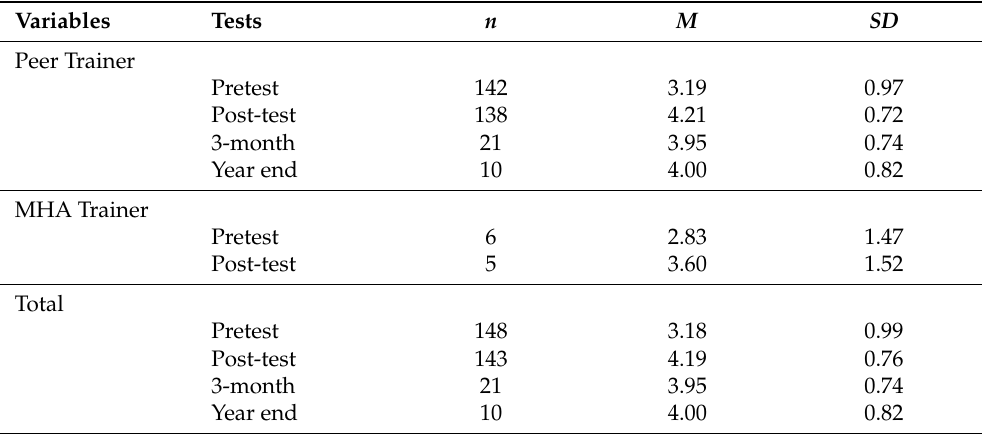
Table 4. Descriptive statistics for perceptions of grief-informed techniques ( n = 321).